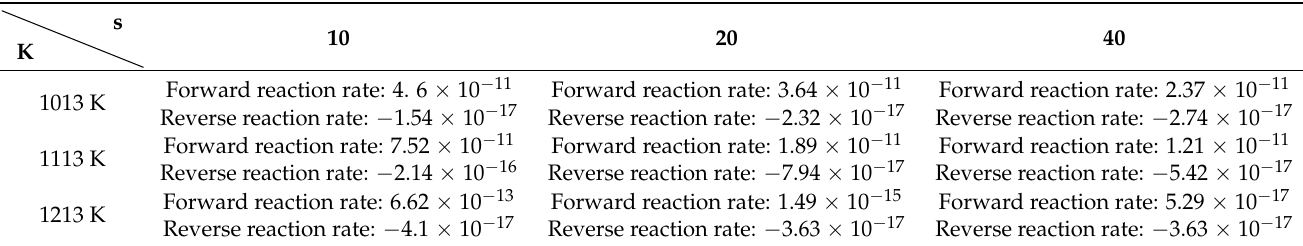
Table 5. Rate of progress between N 2 O and N 2.